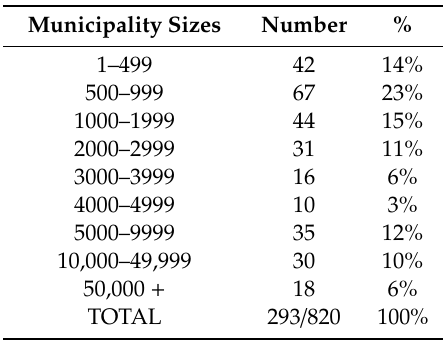
Table 2. Sample size by municipality